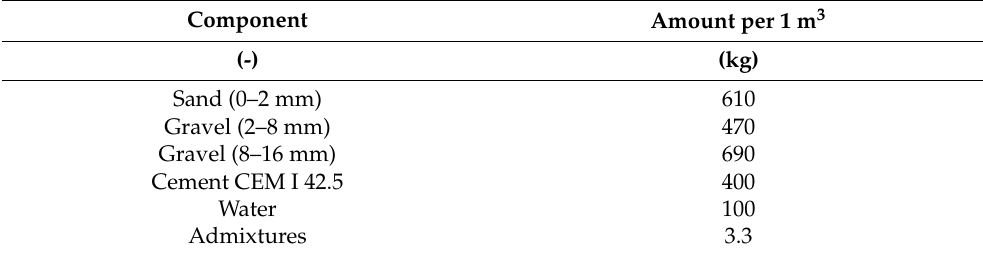
Table 2. The summary of the main components of the concrete mix.